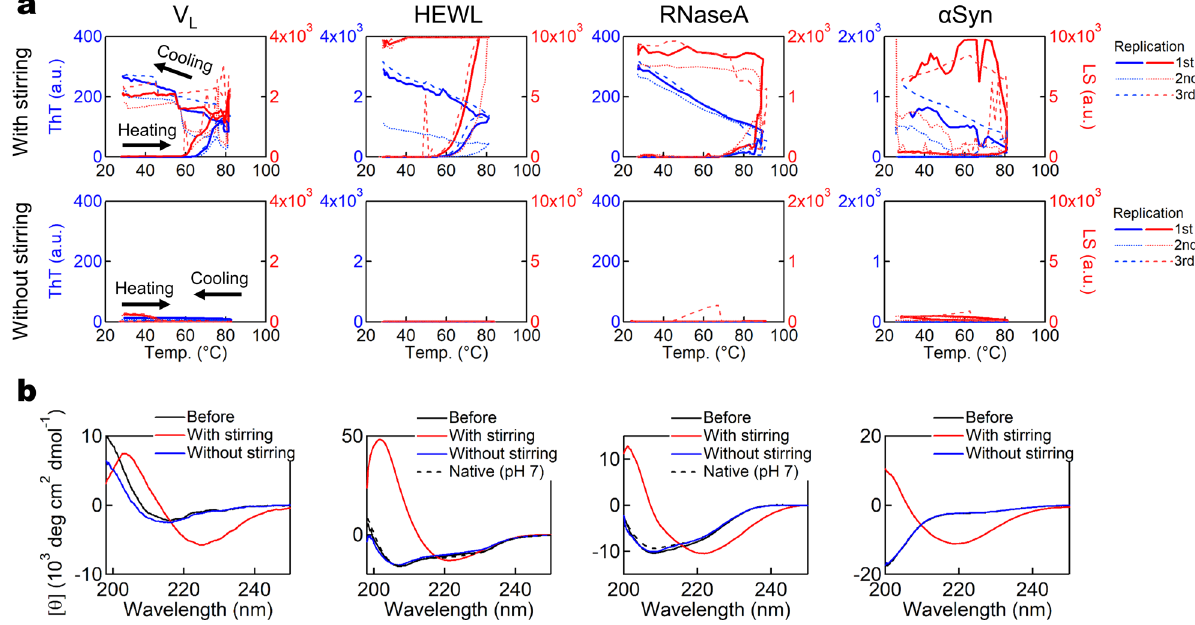
Fig. 1 Heating- and agitation-dependent amyloid formation of type S proteins. a ThT assays of V L , HEWL, RNaseA, and α Syn upon heating in the presence (upper) or absence (lower) of stirring. The intensities of ThT fl uorescence and LS are indicated by blue and red lines, respectively. n = 3 and triplicate runs are shown with helper arrows. b CD spectra of each sample before and after the ThT assays. The line representations are described in the